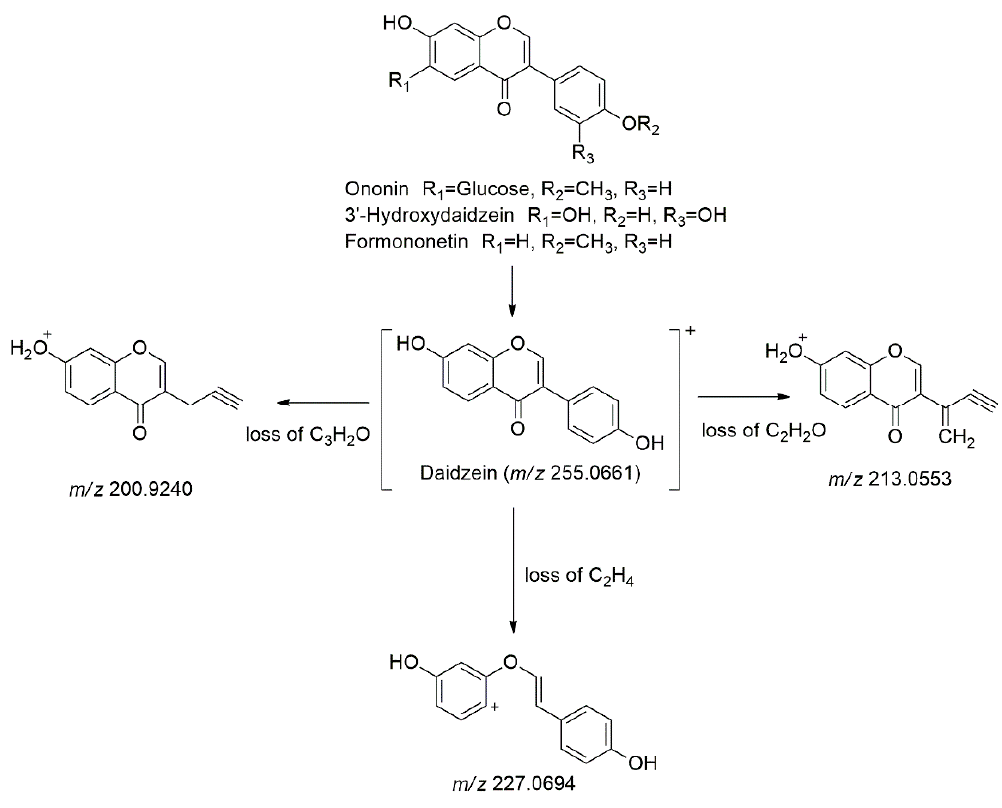
Figure 7. The fragmentation pathways of the daidzein derivatives.